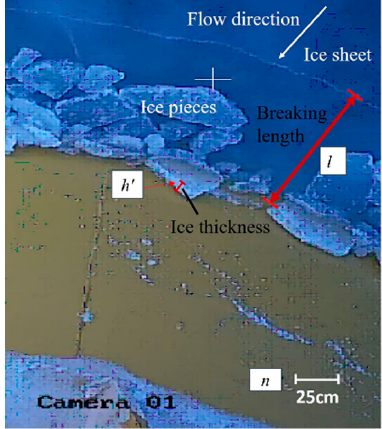
Figure 2. Image monitoring methods of sea ice factors.